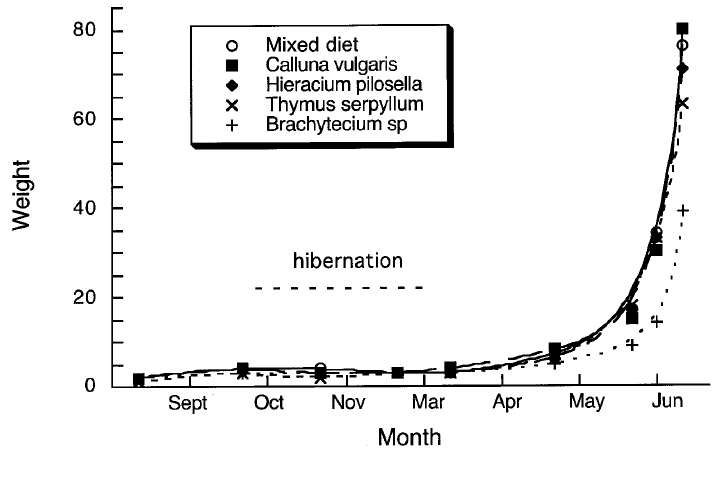
Fig. 1. Mean weight (mg) of D. ancilla larvae reared on different plant species that support- ed development to adult moth. The largest standard deviation in any cohort, at any time, is